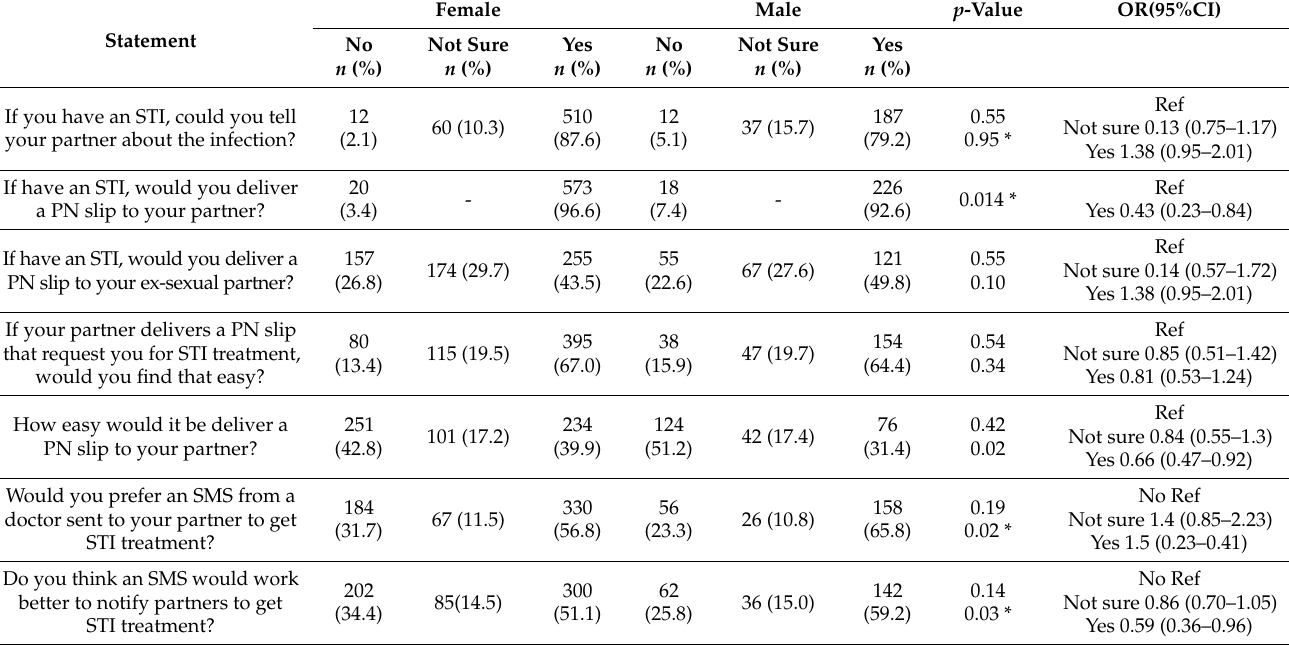
Table 6. Perceptions of and intentions to use STI partner